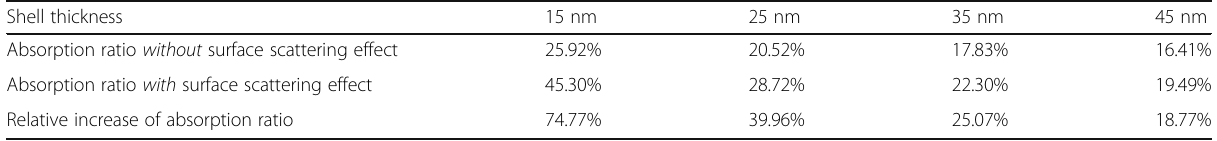
Table 1 Comparison of the absorption ratio between the calculations with and without the surface scattering effect of conduction electrons. The results are obtained from Fig.